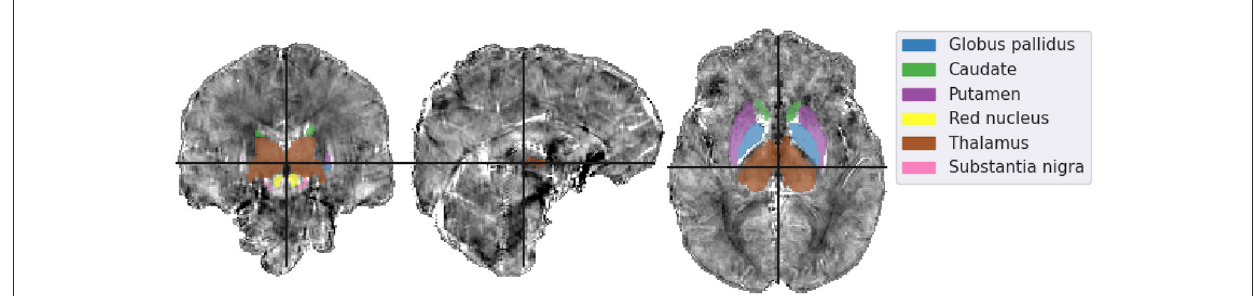
FIGURE9 Mid-plane slices of the incomplete spectrum reconstruction of the same representative healthy volunteer presented in Figures 7, 8. ROIs segmented using MRI Cloud and used in the analysis are overlaid. The colormap of the susceptibility distribution is identical to that of the other presented reconstructions, i.e., between –0.1 and 0.1